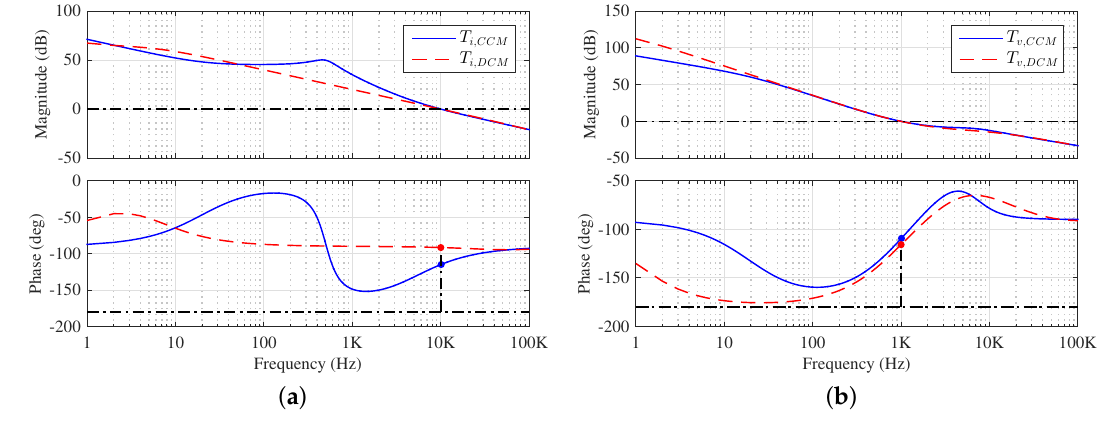
Figure 11. Bode plots of ( a ) T i ( s ) and ( b ) T v ( s ) when P dev , net < 0.